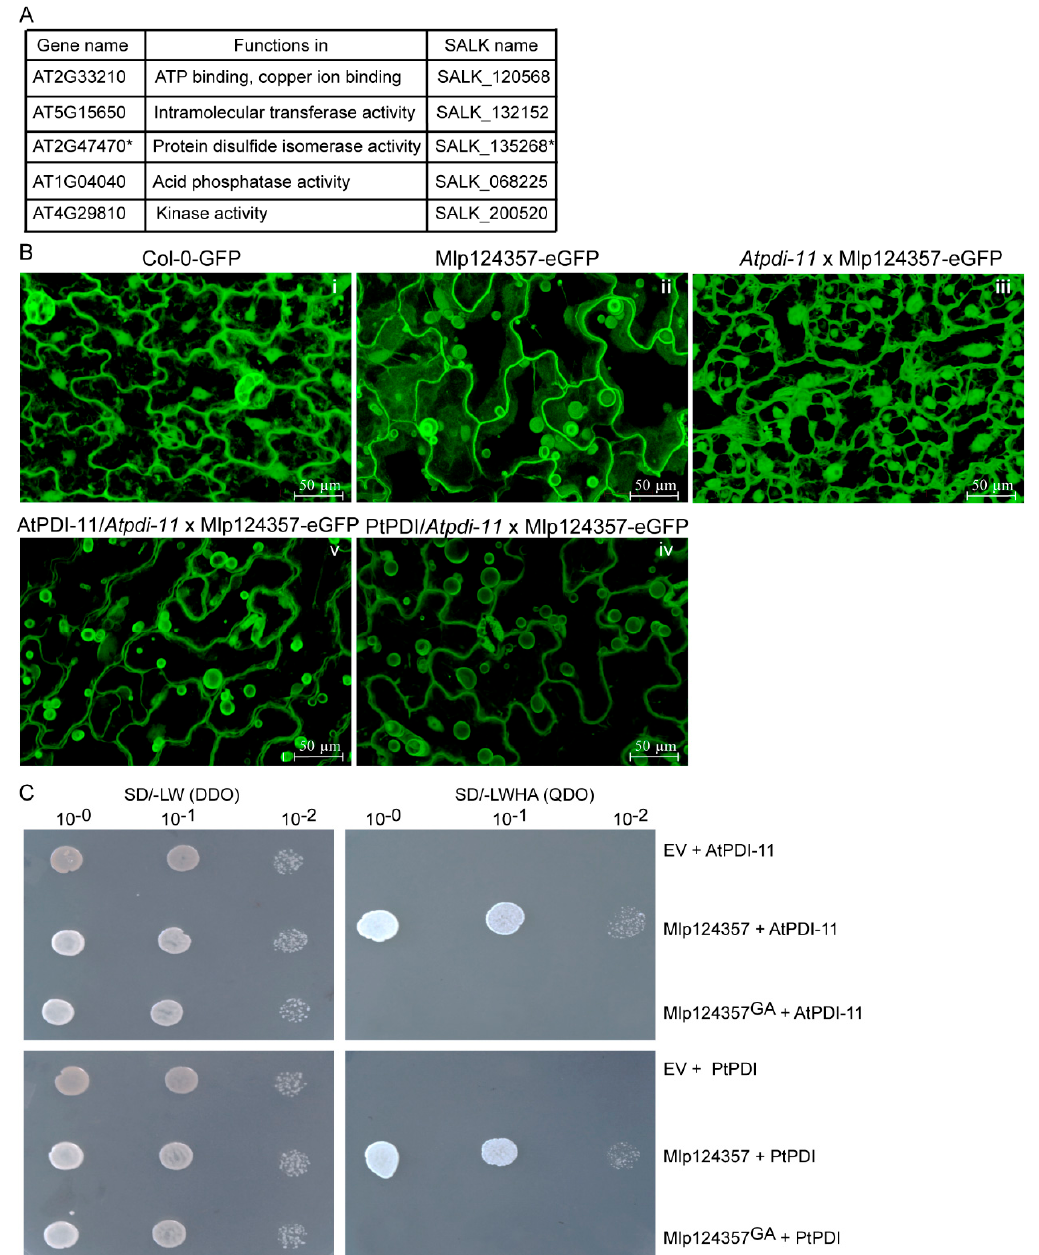
Figure 4. Protein Disulfide Isomerase 11 as a potential plant interactor of Mlp124357. ( A ) The five tonoplast-localized proteins selected from the IP / MS list. ( B ) Interaction between Mlp124357 and AtPDI-11 or PtPDI was detected by a genetic analysis / complementation test. Live-cell imaging of leaf epidermal cells of each genotype. ( C ) Interaction between Mlp124357 and AtPDI-11 or PtPDI was evaluated by Y2H. The plates were photographed 2 days after inoculation.